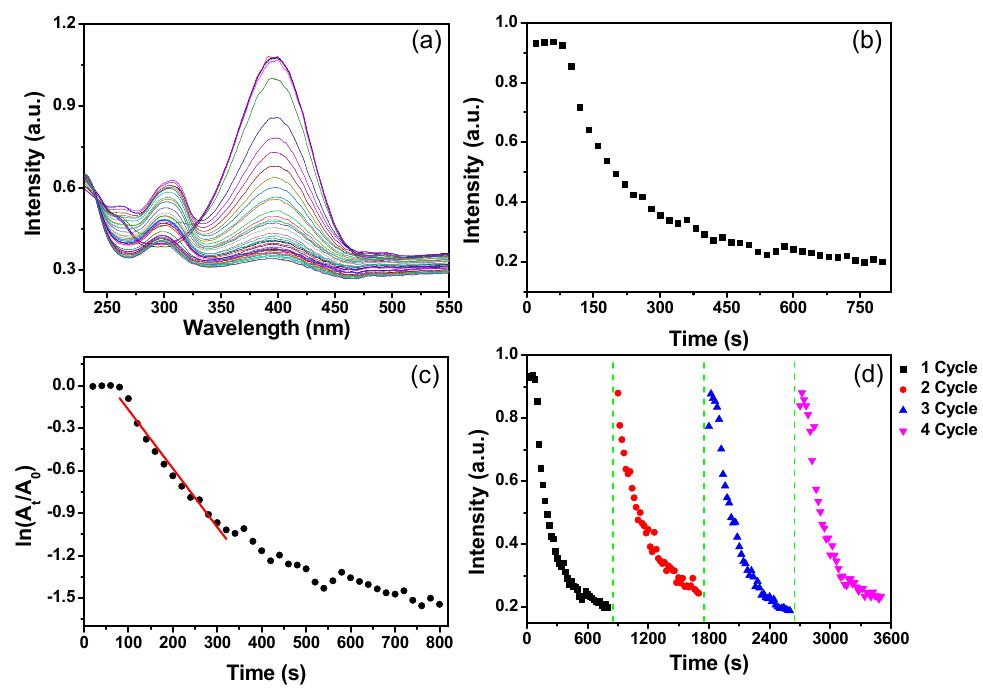
Figure 11. ( a ) Evolution of UV-VIS absorption spectra of 4-nitrophenol solution with wool powder with AuNPs (from 0.04 mM of Au ions) after NaBH 4 solution was added; ( b ) corresponding plots of absorption intensity at 400 nm versus reaction time; ( c ) ln (A t /A 0 ) of absorption peak at 400 nm as a function of reaction time; and ( d ) recycling and reuse of AuNP-WP for the reduction of 4-NP to 4-AP. The time interval between UV-VIS absorption spectra was 20 s.